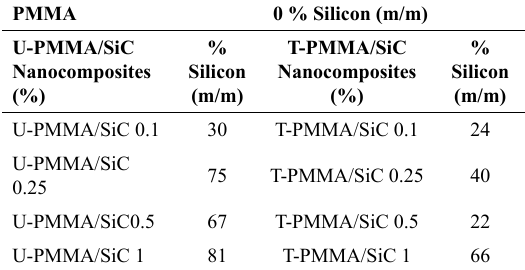
Table 1. Percentages of silicon chemical composition of the U-PMMA\ SiC and T-PMMA\SiC nanocomposites by X-ray fluorescence. PMMA